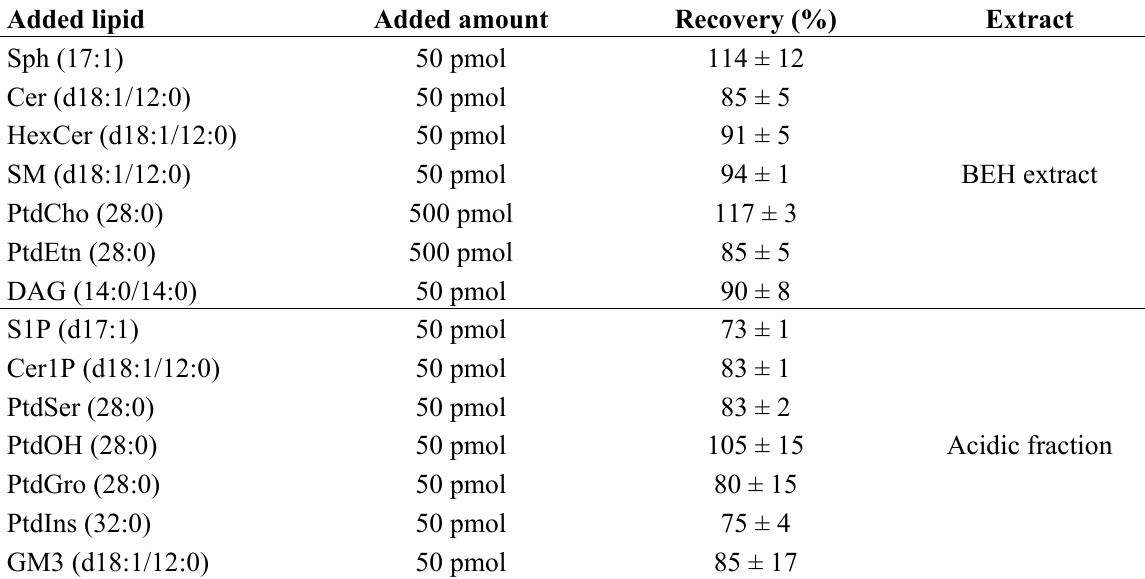
Table 2. Recovery rates of lipid standards added to the cell suspension. The values are expressed as the mean ± SD ( n = 3).